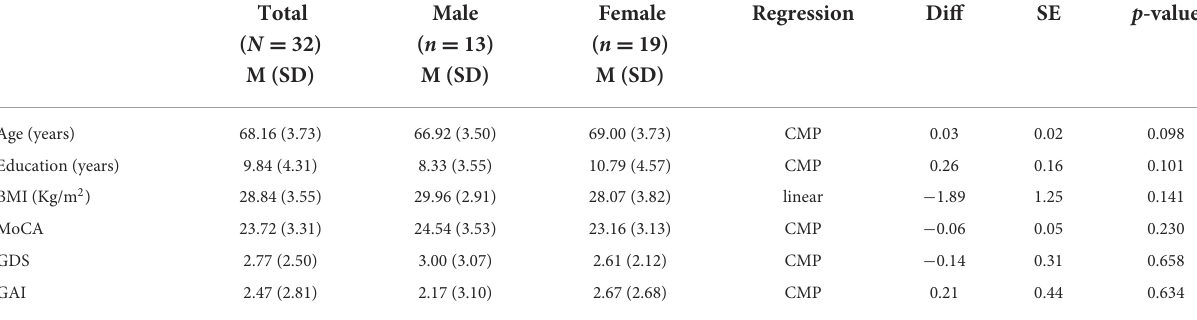
TABLE 1 Sex differences, comparing men (reference level) to women.